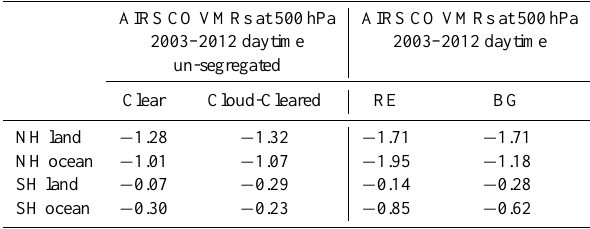
Table 1. The rates of the reduction (negative numbers) and increase (positive numbers) of AIRS CO VMRs at 500hPa for daytime val- ues for the clear and the cloud-cleared (left columns), and for the background values and the recent emissions from under clear con- ditions (right columns). Units are ppbvyr − 1